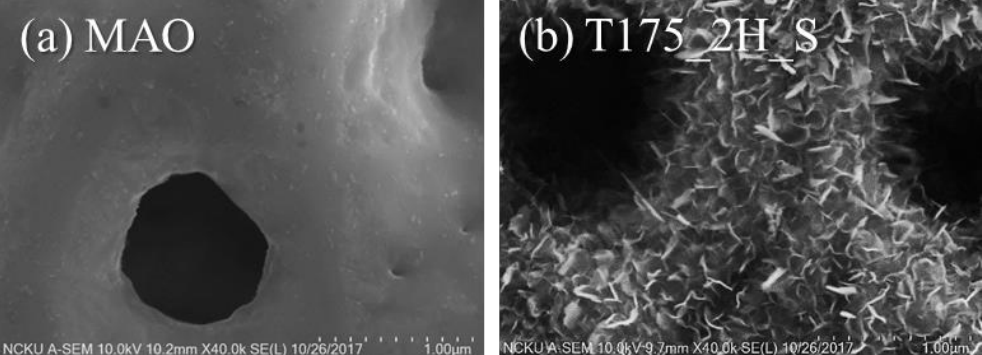
Figure 5. The surface morphology of ( a ) MAO coatings and ( b ) hierarchical structures fabricated using hydrothermal treatment at 175 °C for 2 hours.